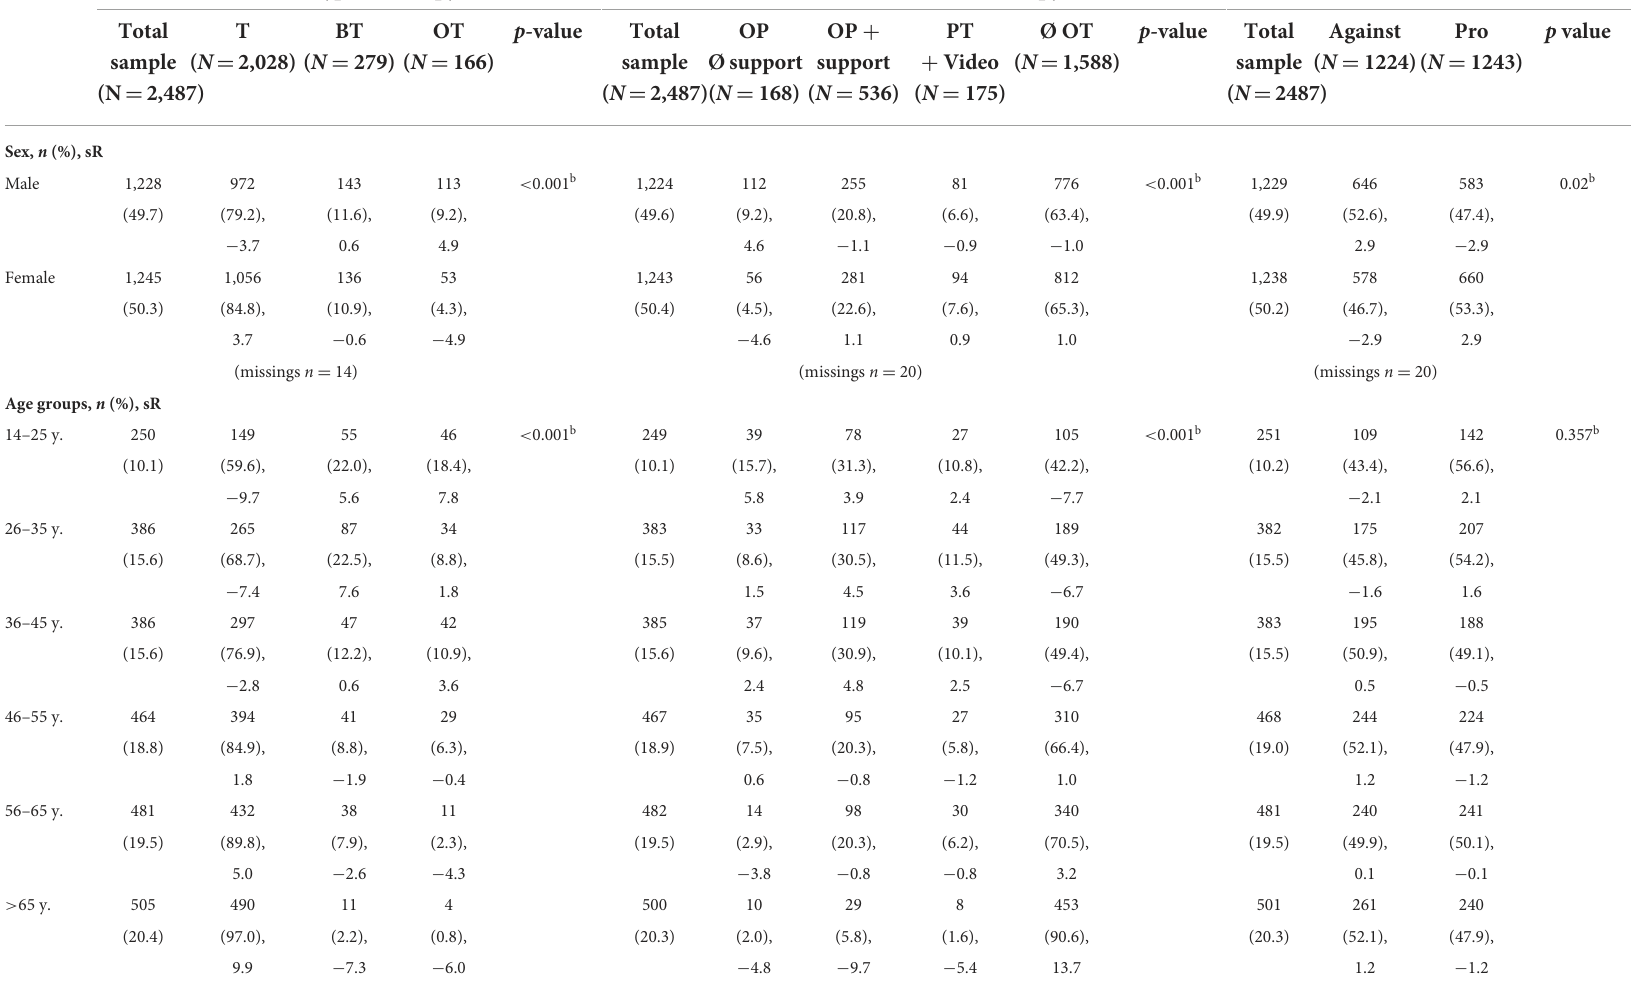
TABLE 2 Statistical associations between variables of interest of